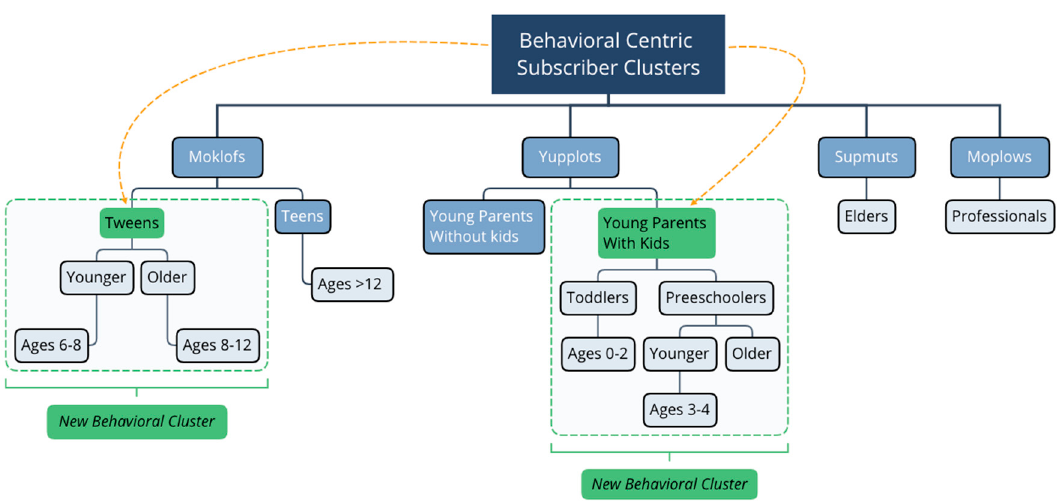
Figure 8. New behavioral-centric subscriber clusters. Moklofs: mobile kids with lots of friends, Yupplots: young parents with lack of time, Supmuts: senior urban people with much time, Moplows: mobile professionals with lots of work.